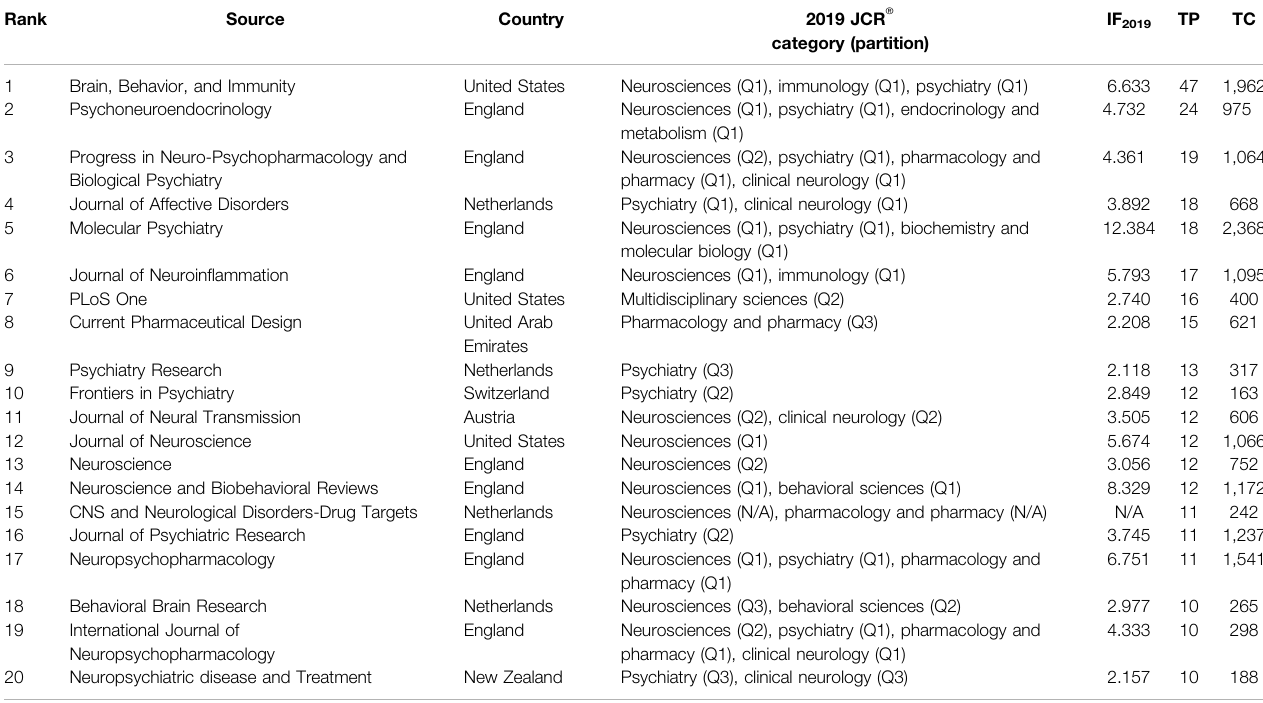
TABLE 1 | The top 20 most relevant journals in the fi eld of the kynurenine pathway (KP) in mood disorders between 2000 and 2020. Rank Source Country 2019 JCR